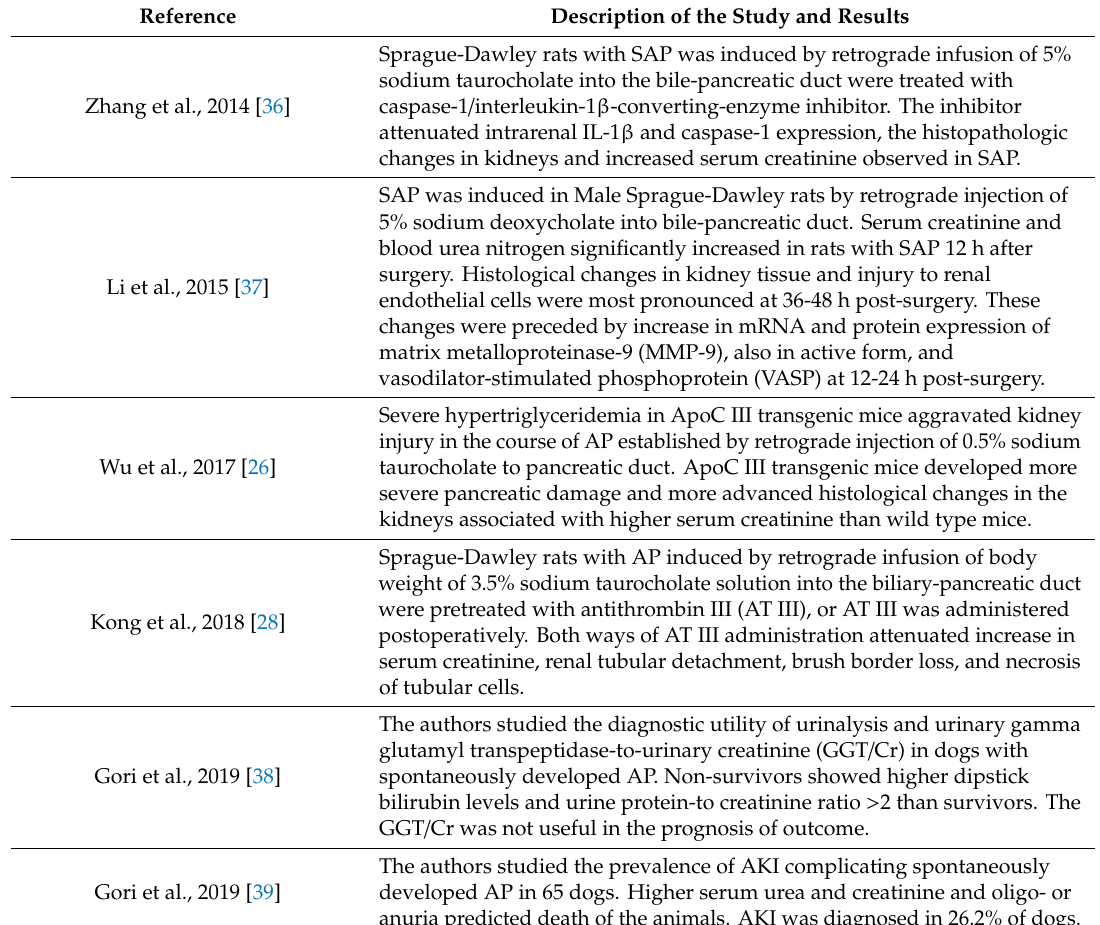
Table 2. The recent evidence on AKI in AP coming from animal